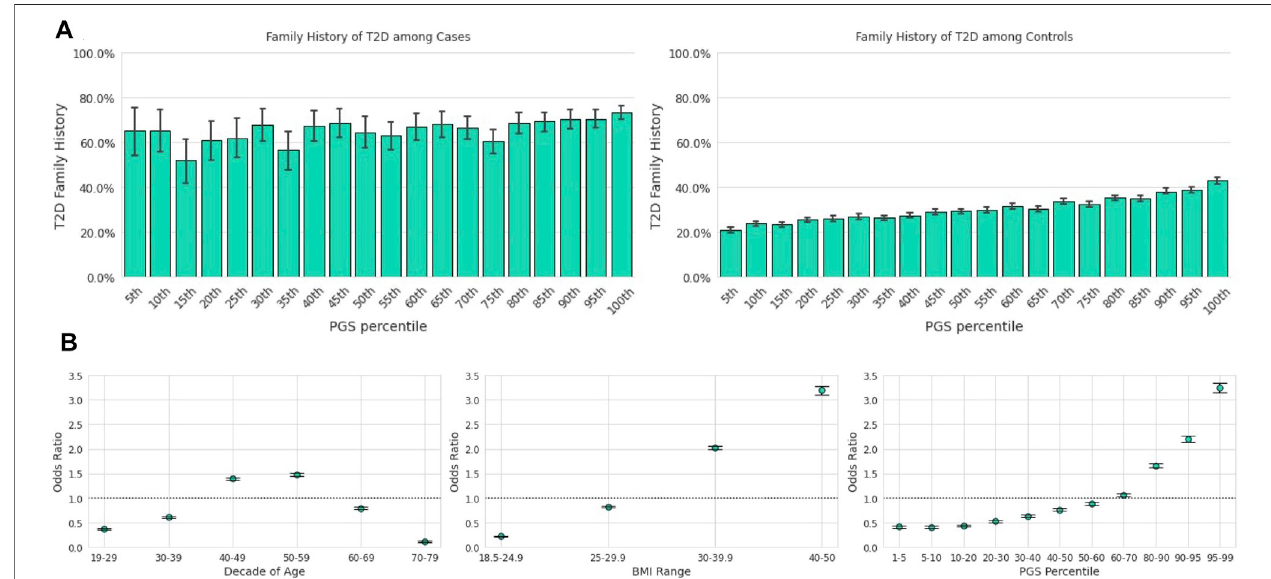
FIGURE 2 | The T2D PGS is a predictor on par with traditional risk factors. Error bars here represent empirically derived 95% con fi dence intervals. (A) : Research participantswhoself-reportedtheirfamilyhistorywerebinarizedintotwogroups:thosewitha fi rst-degreerelativewithT2Dandthosewithout.Thefractionofparticipants with a positive family history of T2D (y-axis) is plotted as a function of PGS ventile (x-axis) among T2D cases (left panel) and T2D controls (right panel). (B) : Unadjusted odds ratios (y-axis) of having T2D relative to the entire study population were calculated for each decade of age (left panel), BMI category (center panel), and PGS percentile (right panel). Error bars represent analytically computed 95% con fi dence intervals.